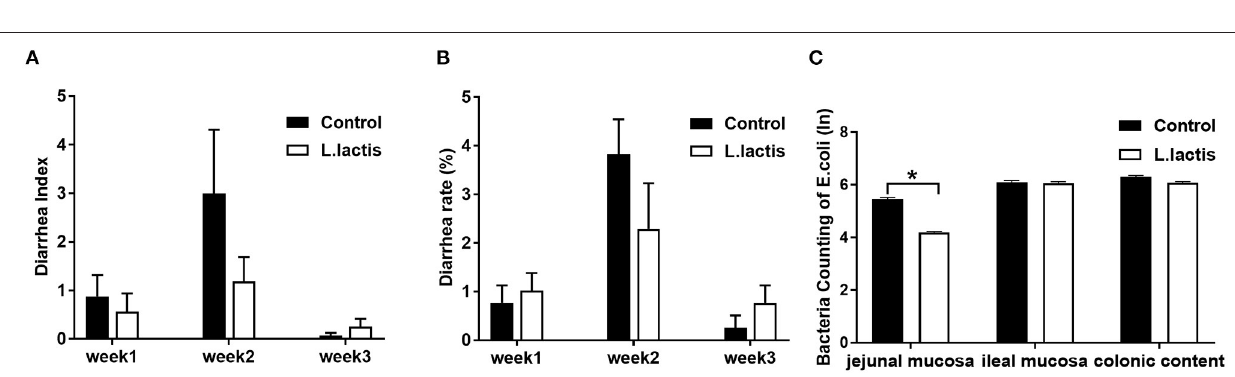
FIGURE 2 | Effects of L.lactis on diarrhea and counting of E.coli . (A) Diarrhea index; (B) diarrhea rate; (C) E.coli count. Wilcoxon rank-sum test was used to analyze the data (mean ± SEM). * P <